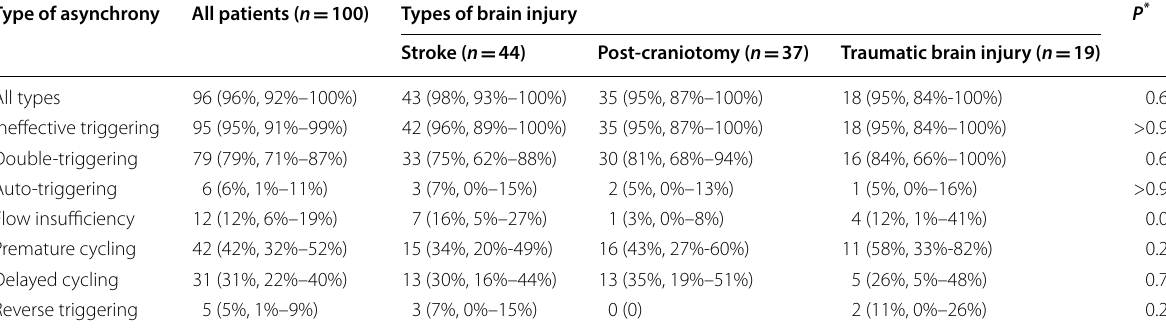
Data are shown as n (%, 95% confidence interval) * Comparison among different classifications of brain injury